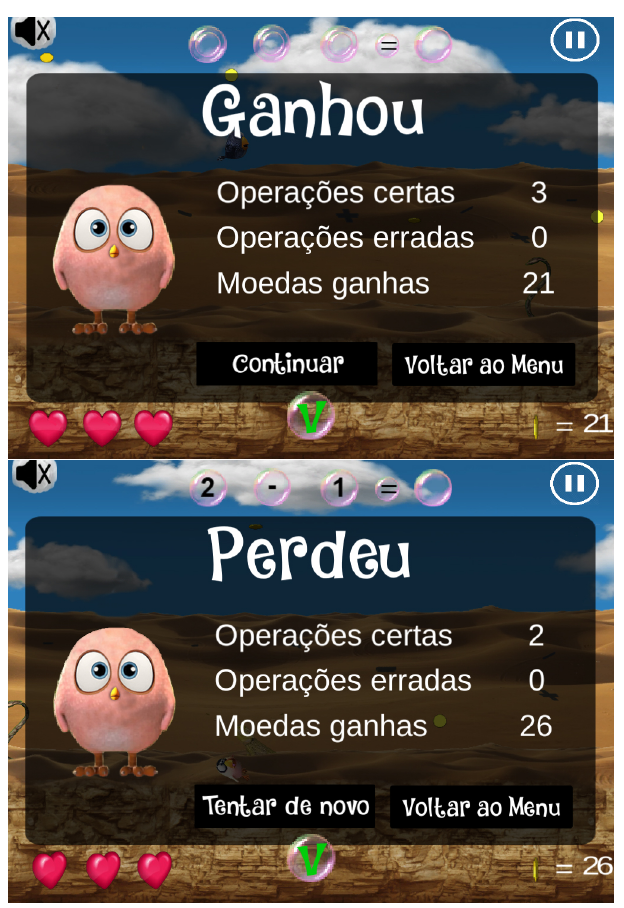
Figure 6. Menus of the game. (a) Main menu. (b) Score